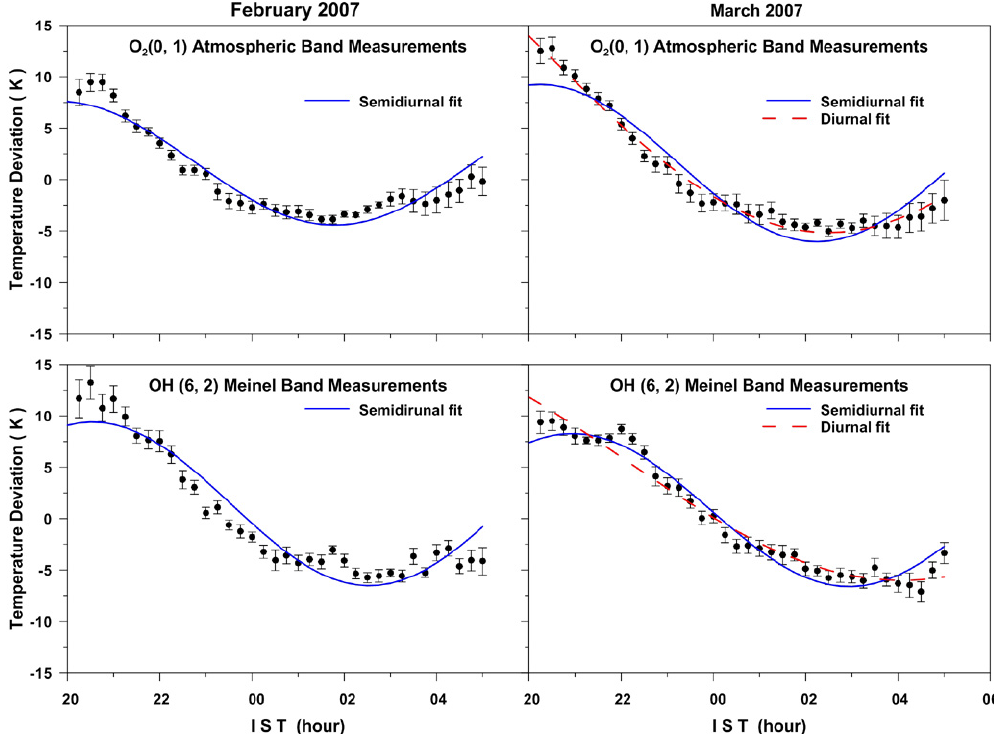
Fig. 6. Averaged nocturnal variation of OH and O 2 temperature for February and March 2007 along with the forced tidal fit based on Lomb–Scargle